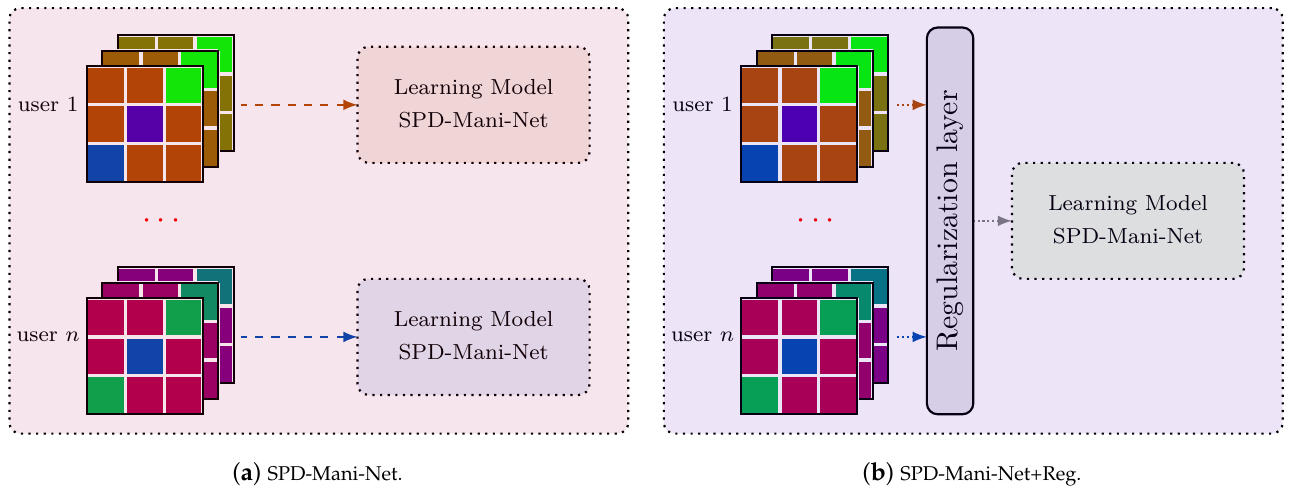
Figure 4. Illustration of the regularization layer from multi-user learning: ( a ) Description of the single-user training model process. ( b ) Description of the process of multi-user joint training model under the regularization